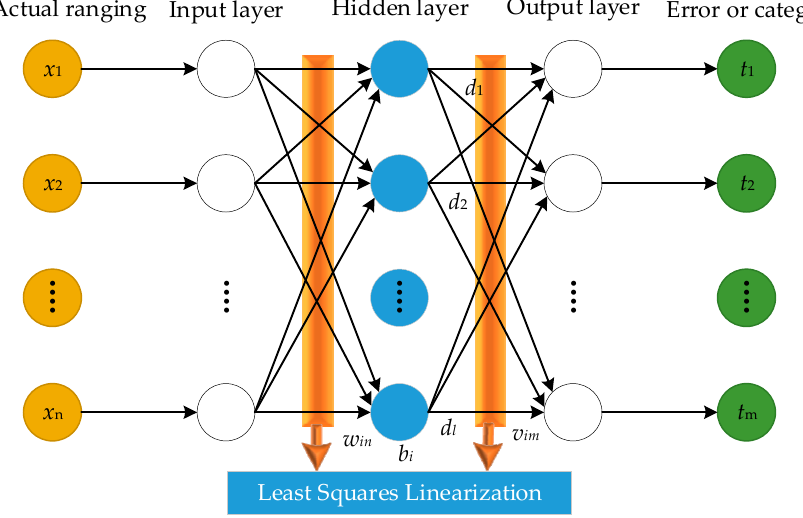
Figure 3. The network topological structure diagram of ELM based on least squares linearization. Suppose there are N groups of training samples for ranging, between four anchors ( A 0 , A 1 , A 2 , A 3 ) and the target, is ( x i , t i ) ∈ R n × R m . Subsequently, the ELM model can be expressed as: